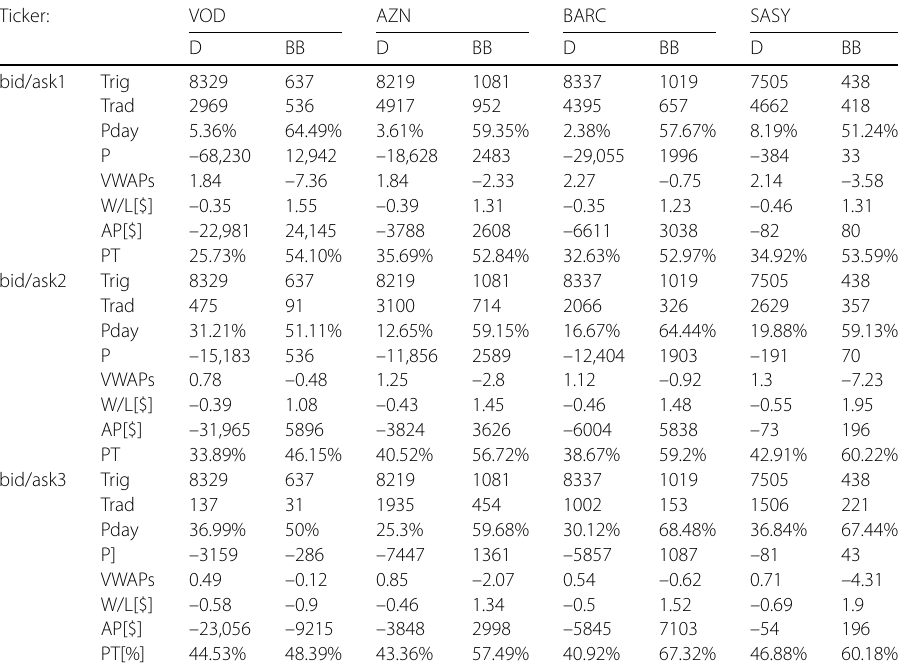
Table 1 Properties of Default and Black Box trading